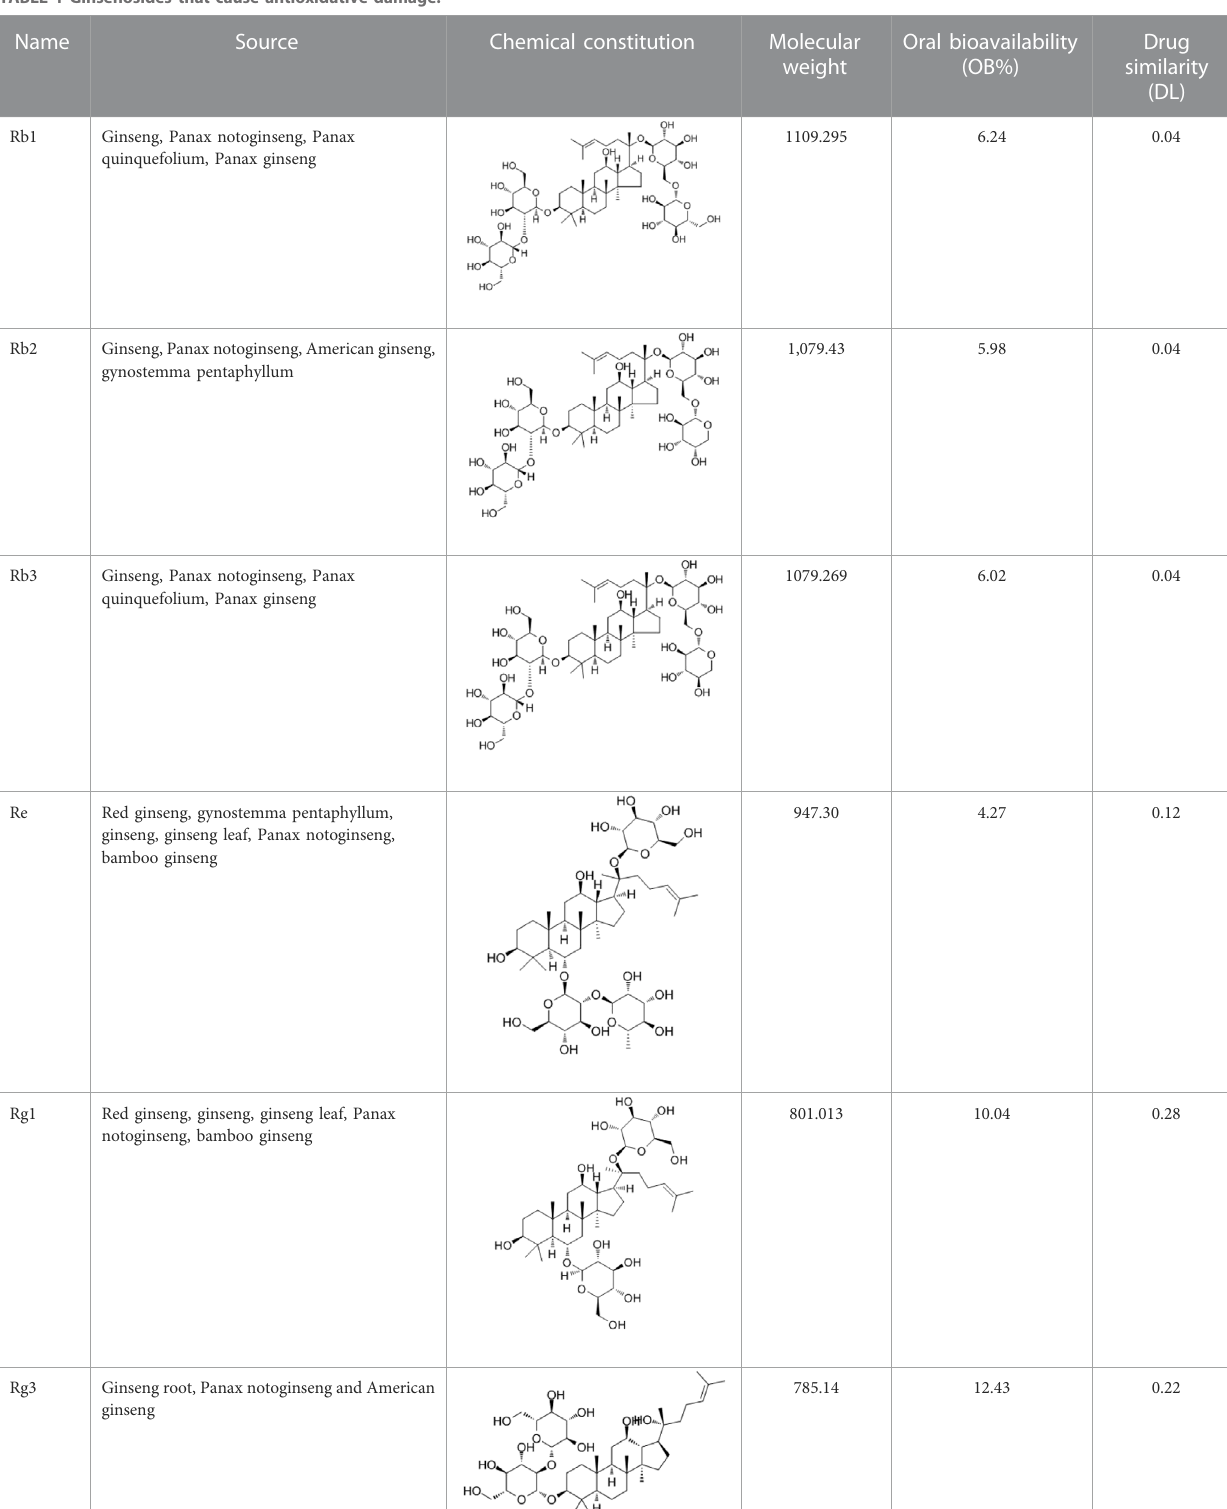
TABLE 1 Ginsenosides that cause antioxidative